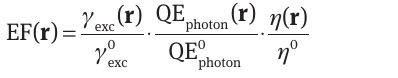
O layer is 5 nm 2 3